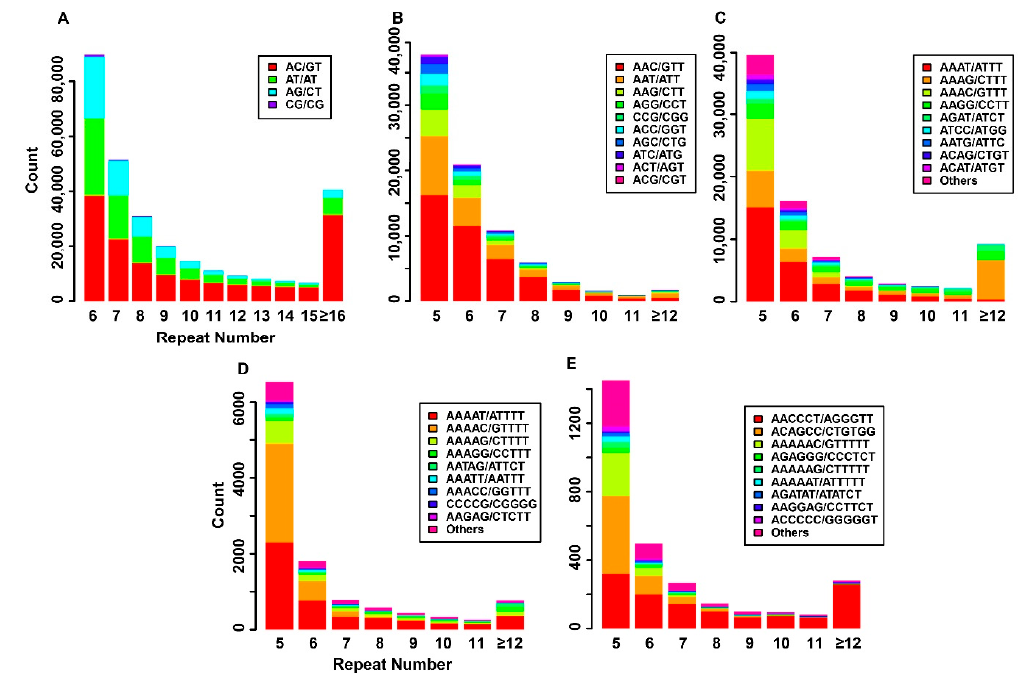
Figure 1. Distributions of repeat units for different simple sequence repeat (SSR) types in the pig reference genome. (A–E) The distributions of repeat units in dinucleotide repeat (Di-SSR), trinucleotide repeat (Tri-SSR), tetranucleotide repeat (Tetra-SSR), pentanucleotide repeat (Penta-SSR) and hexanucleotide repeat (Hexa-SSR). The X axis represents repeat number, Y axis represents the count of the repeat unit corresponding to different colors.